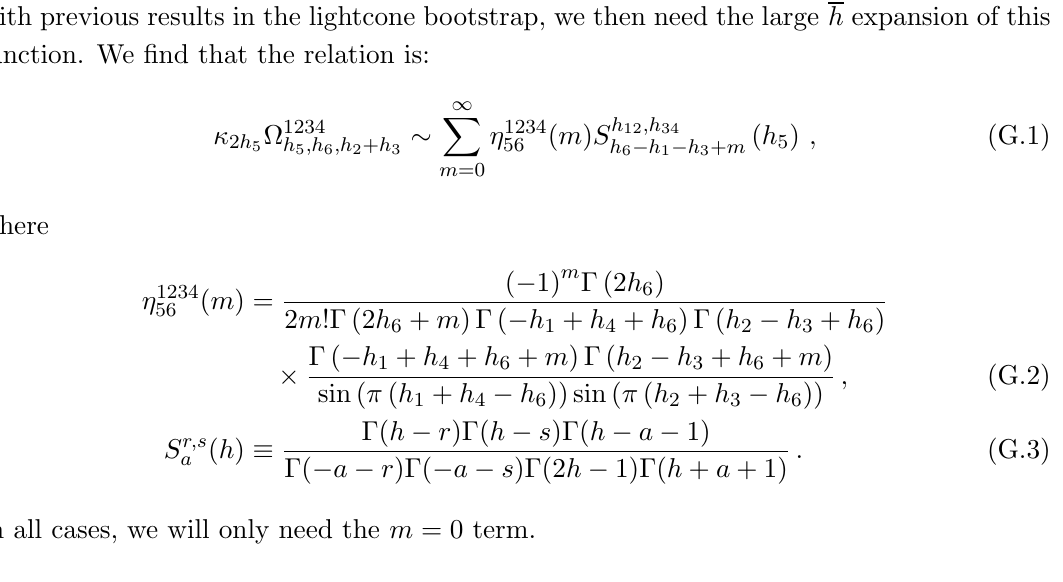
Figure 34 . The e(cid:11)ects of DTIs for OPEs of di(cid:11)erent low-lying double twists in the charge 1 [ (cid:30)t ] 1 odd-spin